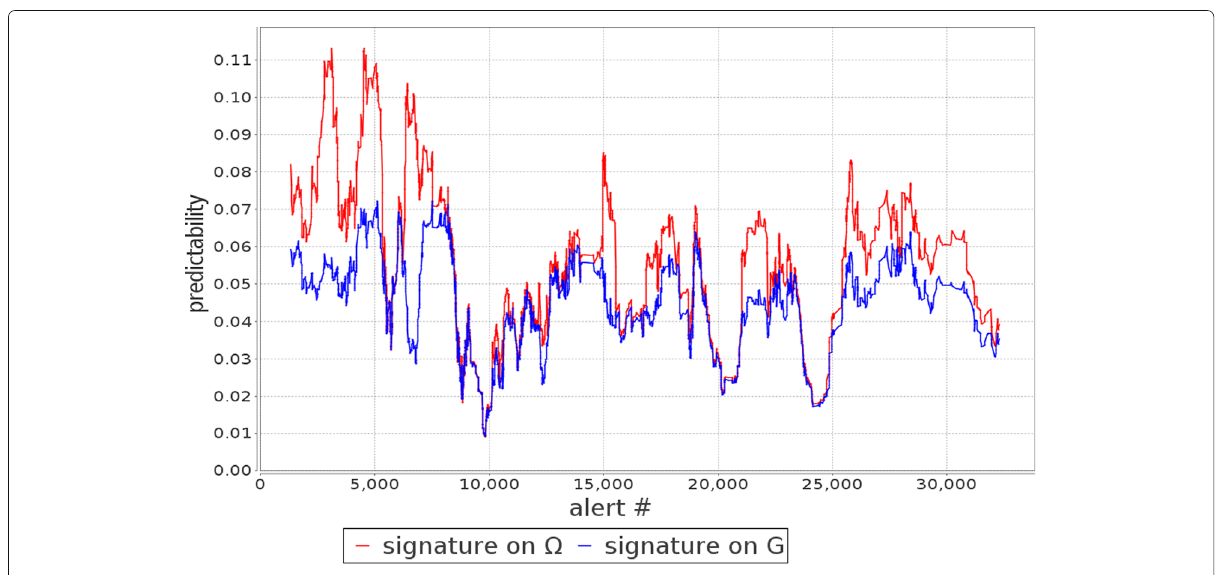
Fig. 11 ˜ q n ((cid:2)) and ˜ q n ( G ) over iterations for the signature